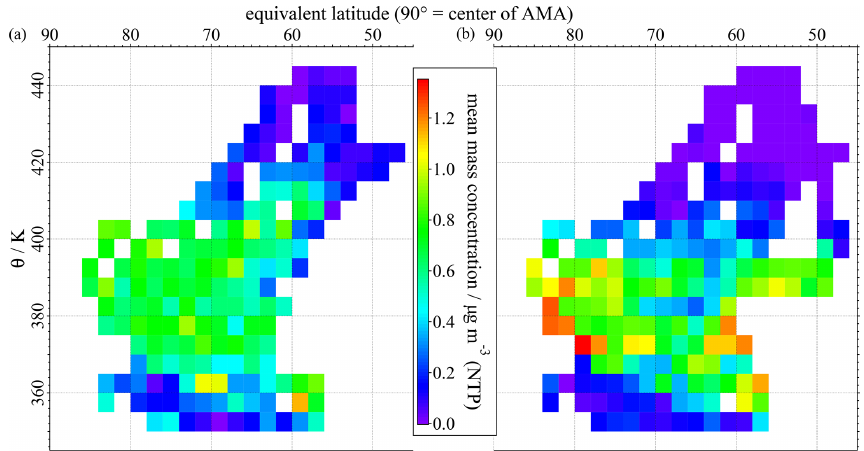
Figure 4. Curtain plot of (a) organic and (b) nitrate mass concentration as a function of θ and equivalent latitude (AMA-centered). The values for organics are based on the data from the Flights 1, and 4 through 8.